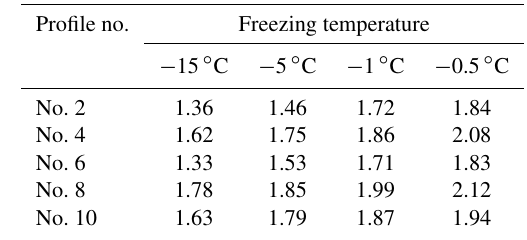
Table 3. The peak shear displacement at the peak points of shear strength (mm).